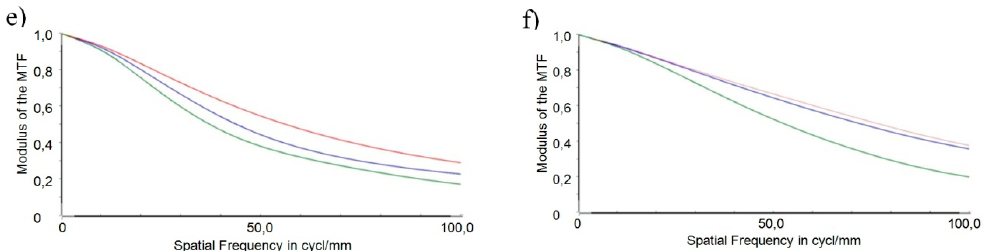
Figure 13. MTF for the different types of position tolerances identified and the robust design for three different adjustments of refraction power: − 0.8 dpt (red), 1.5 dpt (blue), and 3.0 dpt (green).